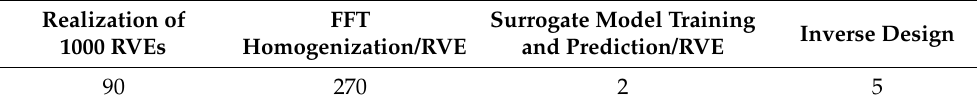
Table 4. Total or average computational times for various processes in minutes.